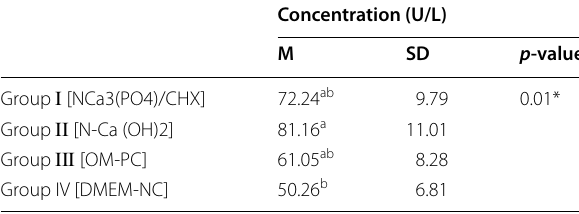
Incubation of HDPSCs treated with different medications for differentiation p : Probability level which is significant at p